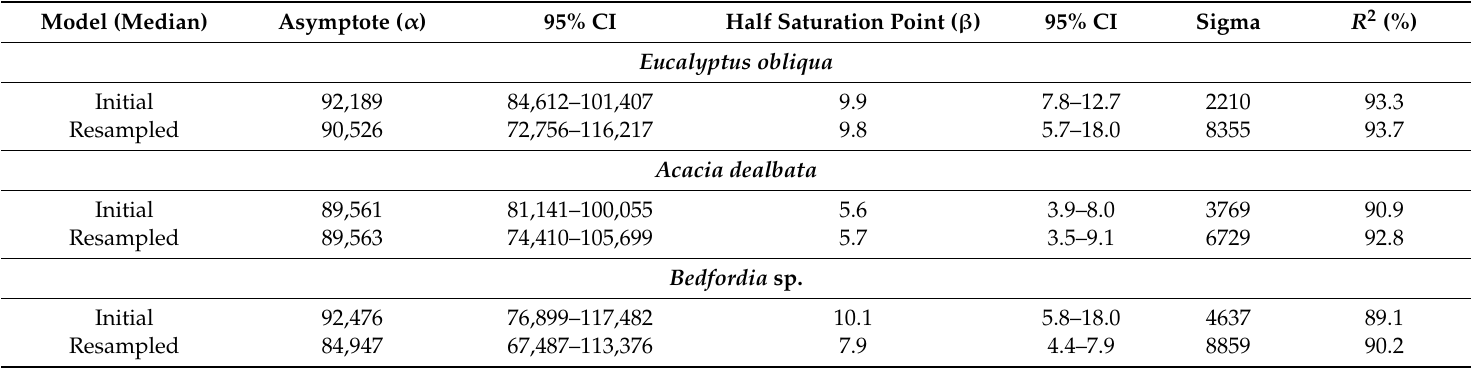
Table 3. The model fit ( R 2 ) for each species for the cumulative CO 2 evolved from the decomposition of the litter: Initial Michaelis–Menten equation fit to the median data points, and the resampled data (median model prediction). Shown is the asymptote ( α ), half saturation point ( β ), and corresponding 95% confidence intervals, for each